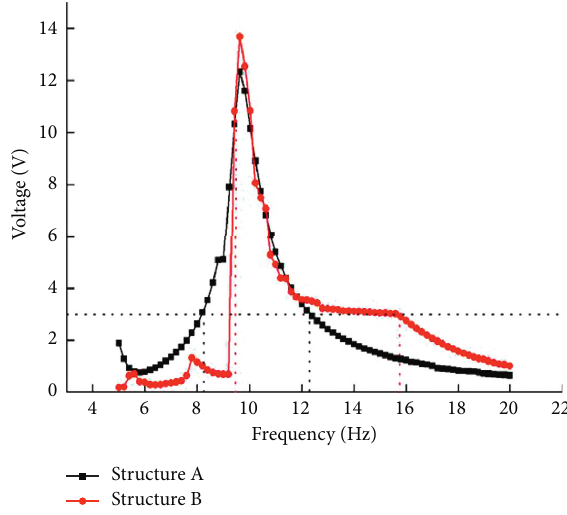
Figure 10: Relation of the frequency-voltage of the structure A and the structure B is given when the initial magnetic distance of the structure B is